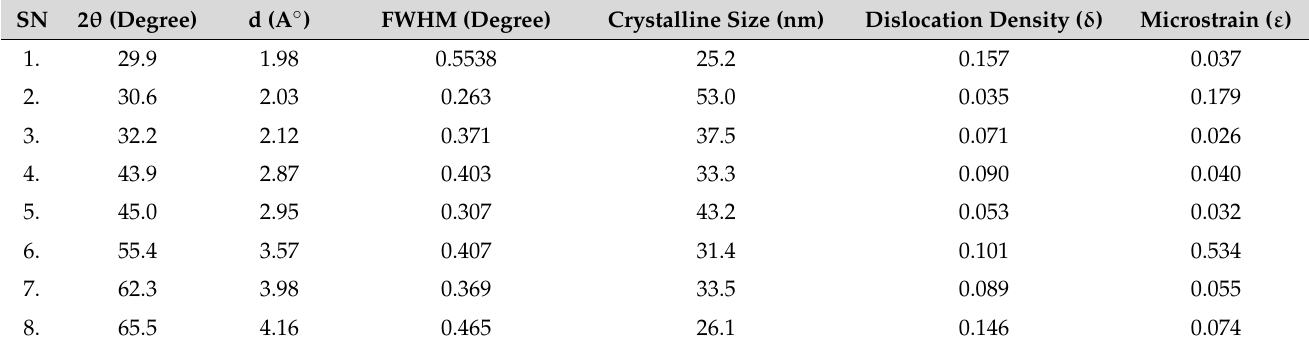
Figure 2. X-ray diffraction (XRD) image to evaluate physical and structural characteristics of synthe- sized tin nanoparticles (SnNPs). Table 1. Crystalline size estimation of elemental SnNPs calculated using Scherrer equation.